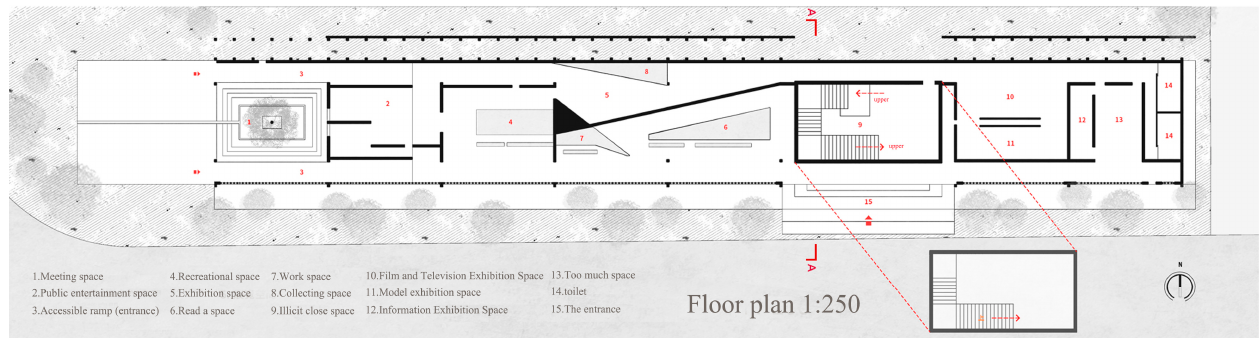
Figure 11. Functional Distribution Diagram of the